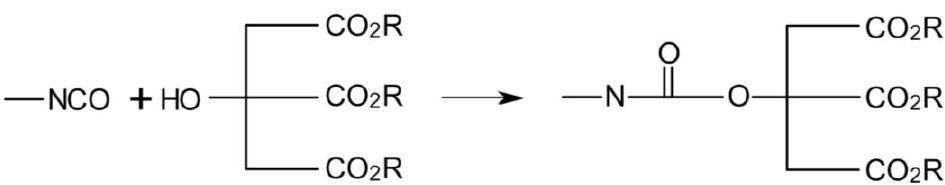
Figure 5. Scheme of isocyanate reaction with triethyl